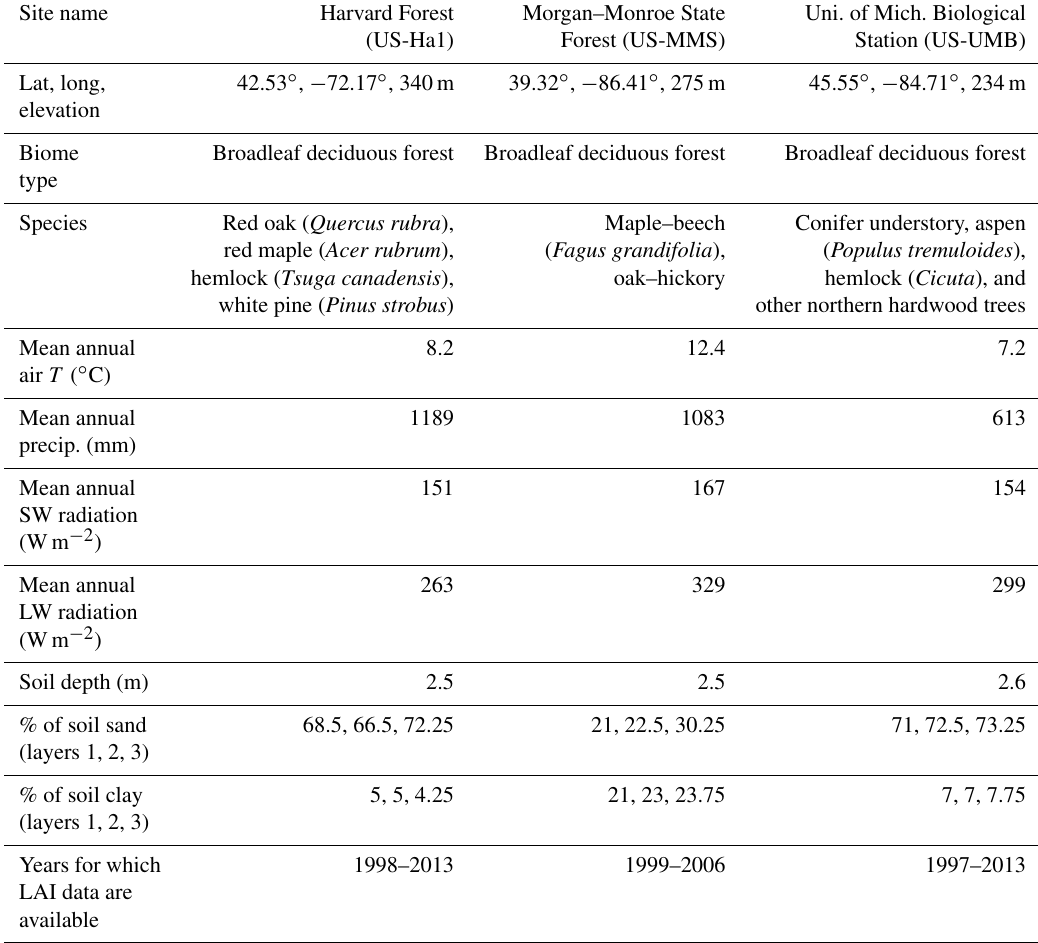
Table 2. The location of FLUXNET sites, primary species that exist at these sites, their soil physical characteristics, mean annual values of primary meteorological variables, and years of data